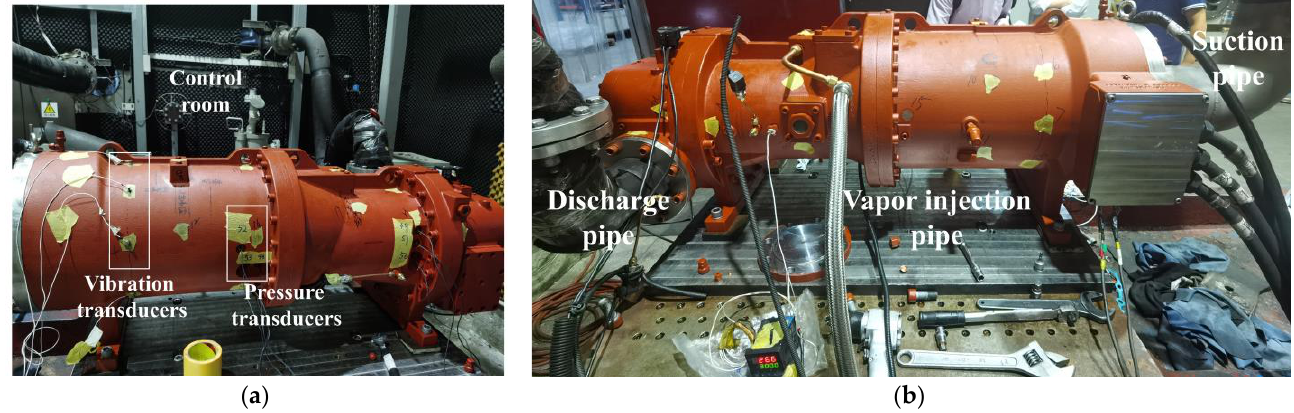
Figure 12. Photos of refrigerant compressor test system: ( a ) the front view; ( b ) the back view.